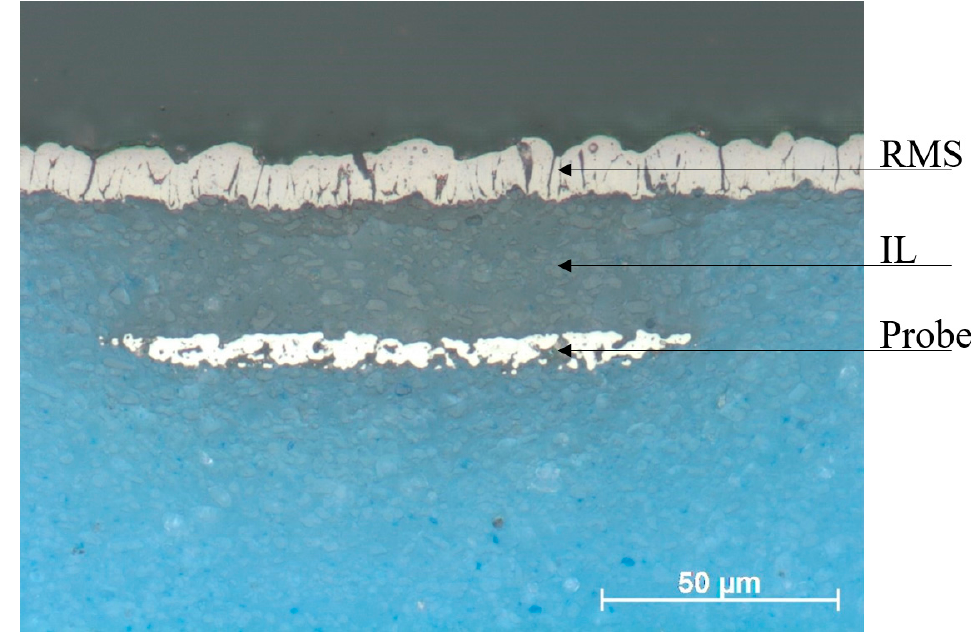
Figure 4. Cross section performed with light microscope.